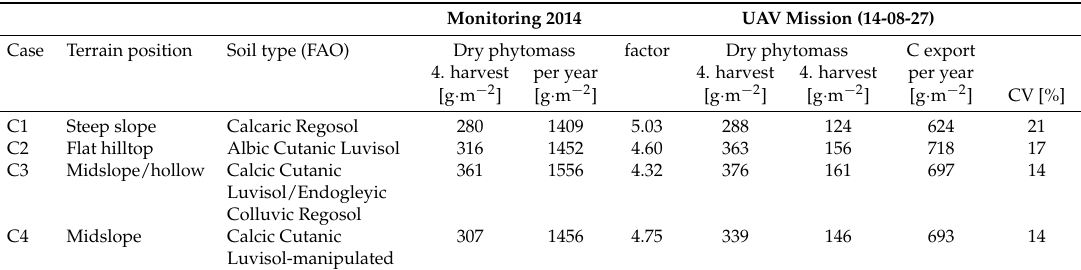
Table 4. Yearly estimates of dry phytomass production and C export from four different Terrain/Soil type combinations (C1–C4) calculated from UAV imagery and ground based monitoring data.